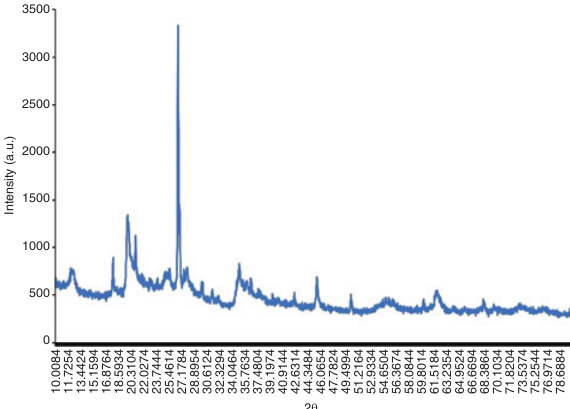
Figure 1: XRD spectra of Cu(OH)